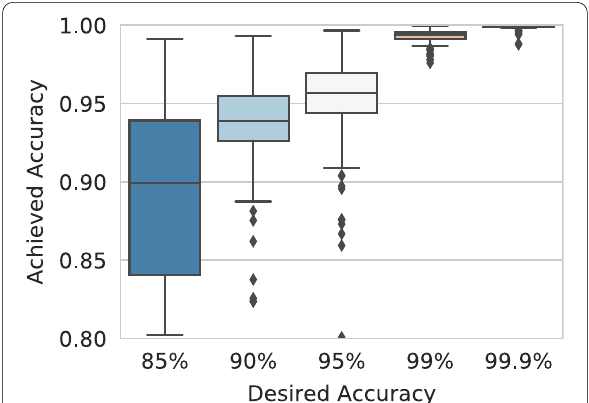
Fig. 5 Boxplot of achieved accuracy over different desired